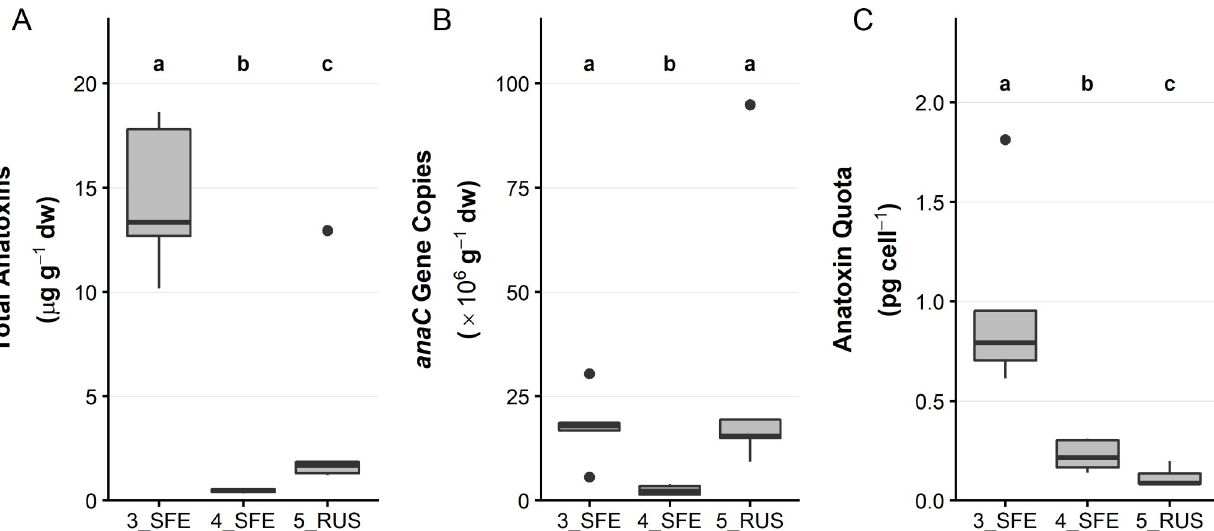
Fig 4. Anatoxin concentrations, anaC gene copies and anatoxin quota among three sites on the Eel and Russian rivers. (A) Summed anatoxin concentrations; (B) anaC gene copies; and (C) anatoxin quota, from five attached periphyton samples collected from two sites on the Eel River and one site on the Russian River. dw = dried weight. Note the different y -axis scales. See Fig 2 for interpretation of boxplots. A Kruskal-Wallis test and pairwise Wilcoxon rank sum test with a Benjamini-Hochberg adjustment was used to identify sites that were significantly different from one another (p < 0.05), denoted by the letter above the